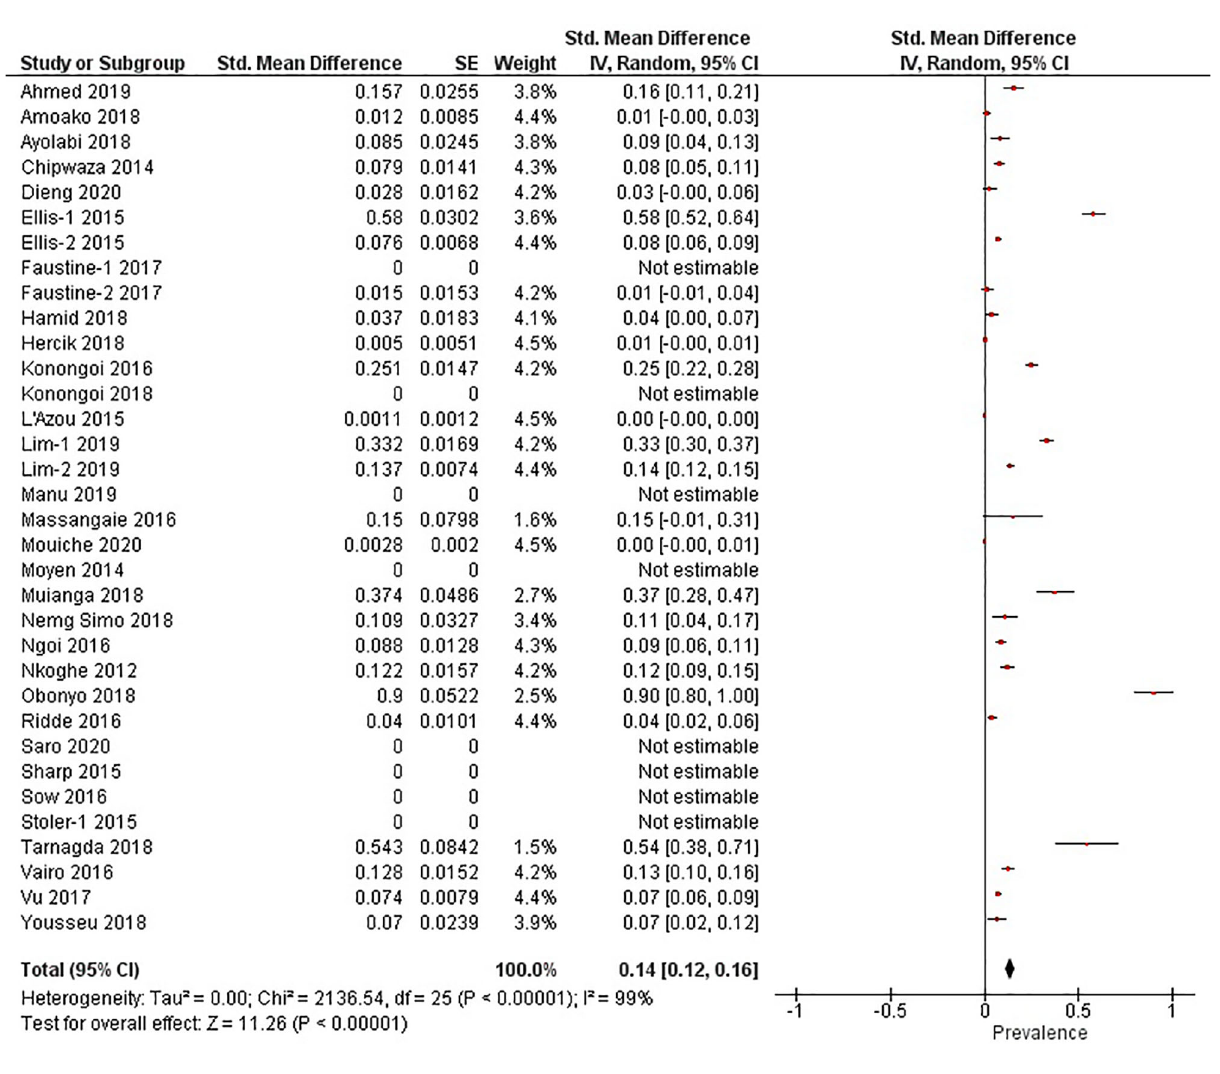
FIGURE 5 | The pooled prevalence of Dengue Virus RNA in Sub-Saharan African population between